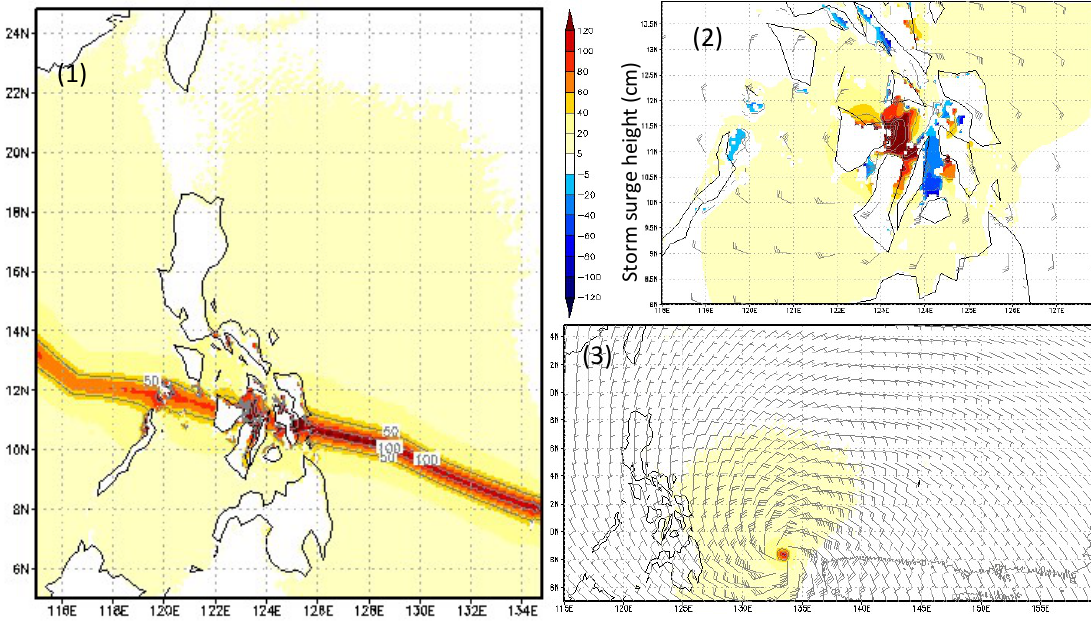
Figure 1. Domains used for simulating the storm surge height using JMA (Japan Meteorological Agency) storm surge model.